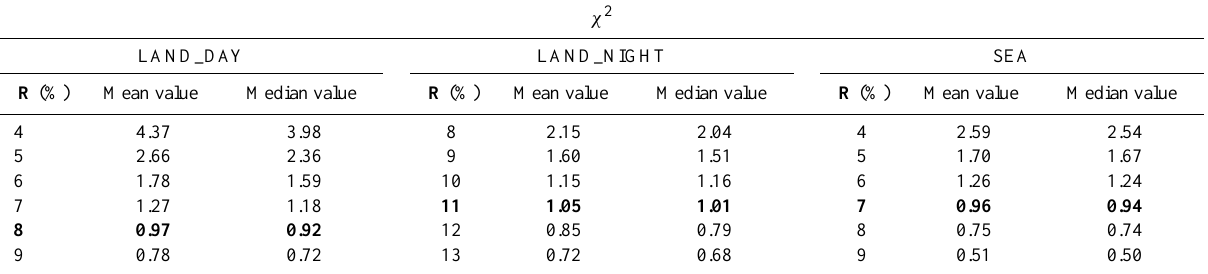
Table 1. Mean and median values of chi-square ( χ 2 ) test for different error values of MOPITT V3 total column observations. The error values of the observations for which the χ 2 test is the closest to 1 are indicated in boldface. They are 8% for LAND_DAY, 11% for LAND_NIGHT and 7% for SEA. These error values are fixed within the assimilation system for all experiments concerning MOPITT V3 total columns. χ 2 LAND_DAY LAND_NIGHT SEA R